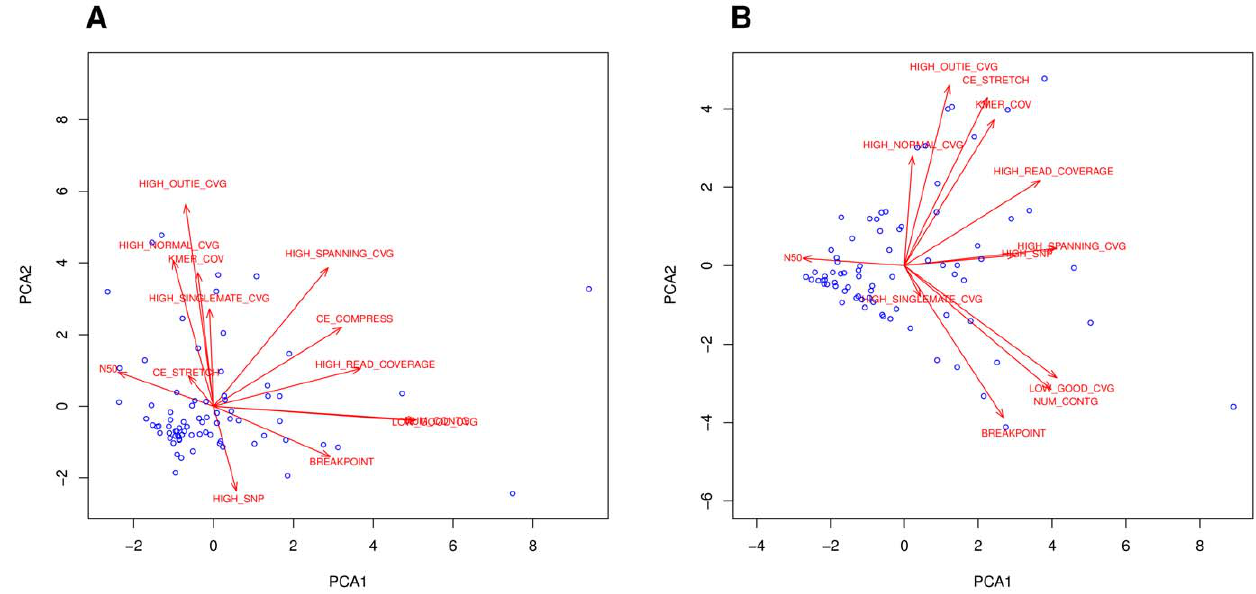
Figure 1. First PC versus Second PC: Long Reads Datasets. The plots in Figure A and B show the results of plotting the first principal component against the second computed on real and simulated datasets respectively. The blue dots represent the assemblies.